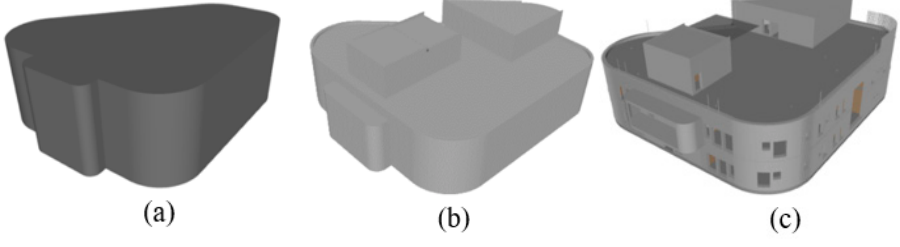
Figure 9. ( a ) LOD1, ( b ) LOD2 conversion, and ( c ) the original model.